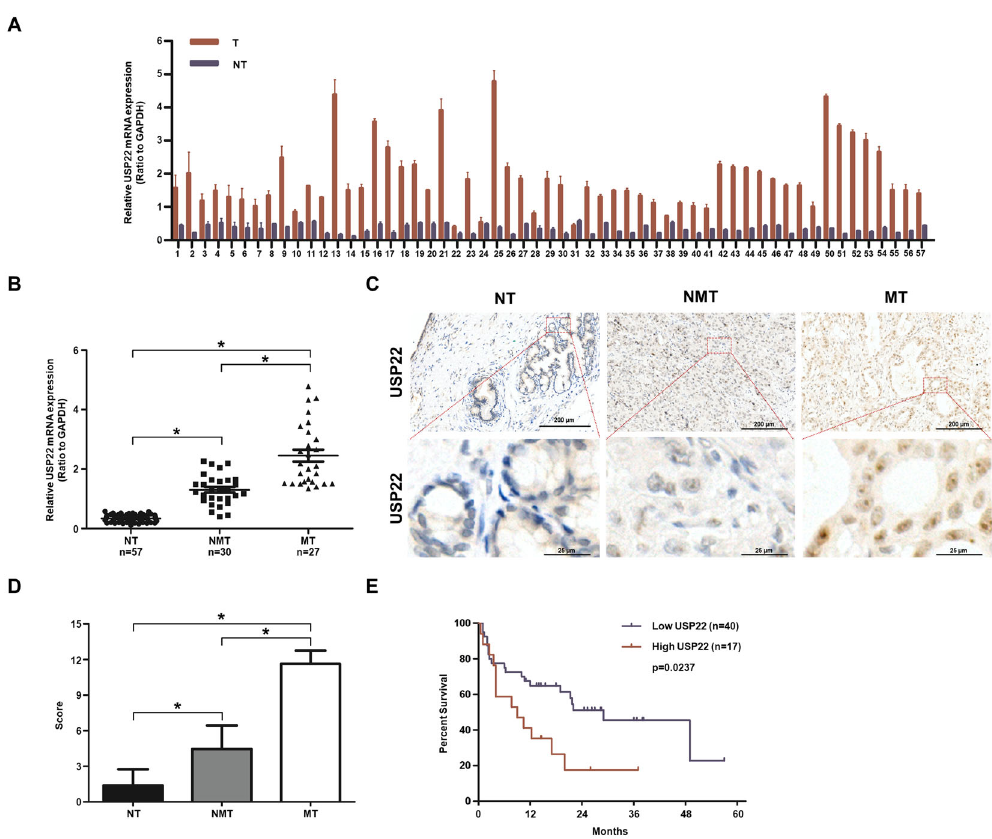
Fig. 1 Worse prognostic signi fi cance of USP22 overexpression in iCCA. A RNAs from paired iCCA and adjacent normal tissues from individual patients ( n = 57) were respectively extracted and quanti fi ed for USP22 mRNA expression by qPCR. B Levels of USP22 mRNA were higher in iCCA than the adjacent normal tissues (NT) ( n = 57) (* p < 0.05), particularly those with metastatic tumours (MT) ( n = 27) vs non- metastatic tumours (NMT) ( n = 30) ( p < 0.05). C IHC for USP22 in iCCA and the adjacent normal tissue sections were performed, showing the nuclear localisation of UPS22 (scale bar = 100 µM or 200 µM). D High scores of USP22 expression were signi fi cantly elevated in iCCA tissues, particularly in MT ( n = 27) vs NT ( n = 57) or NMT ( n = 30) (* p < 0.05). E Kaplan – Meier survival curves showed a signi fi cant correlation of the high USP22 group ( n = 16) with worse overall survival than the low expression group ( n = 41) (* p <